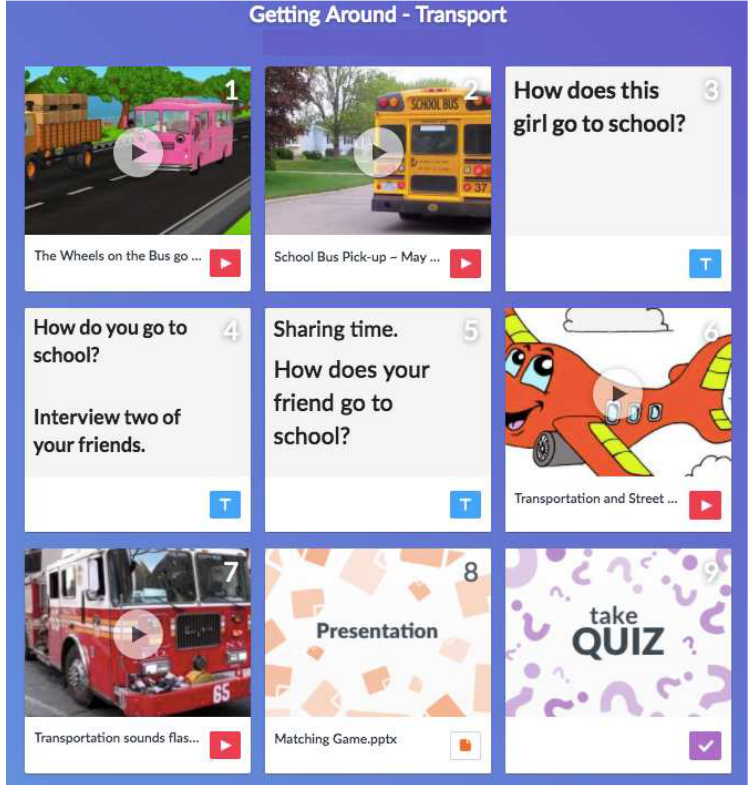
Figure 6: Cempaka’s Blendspace